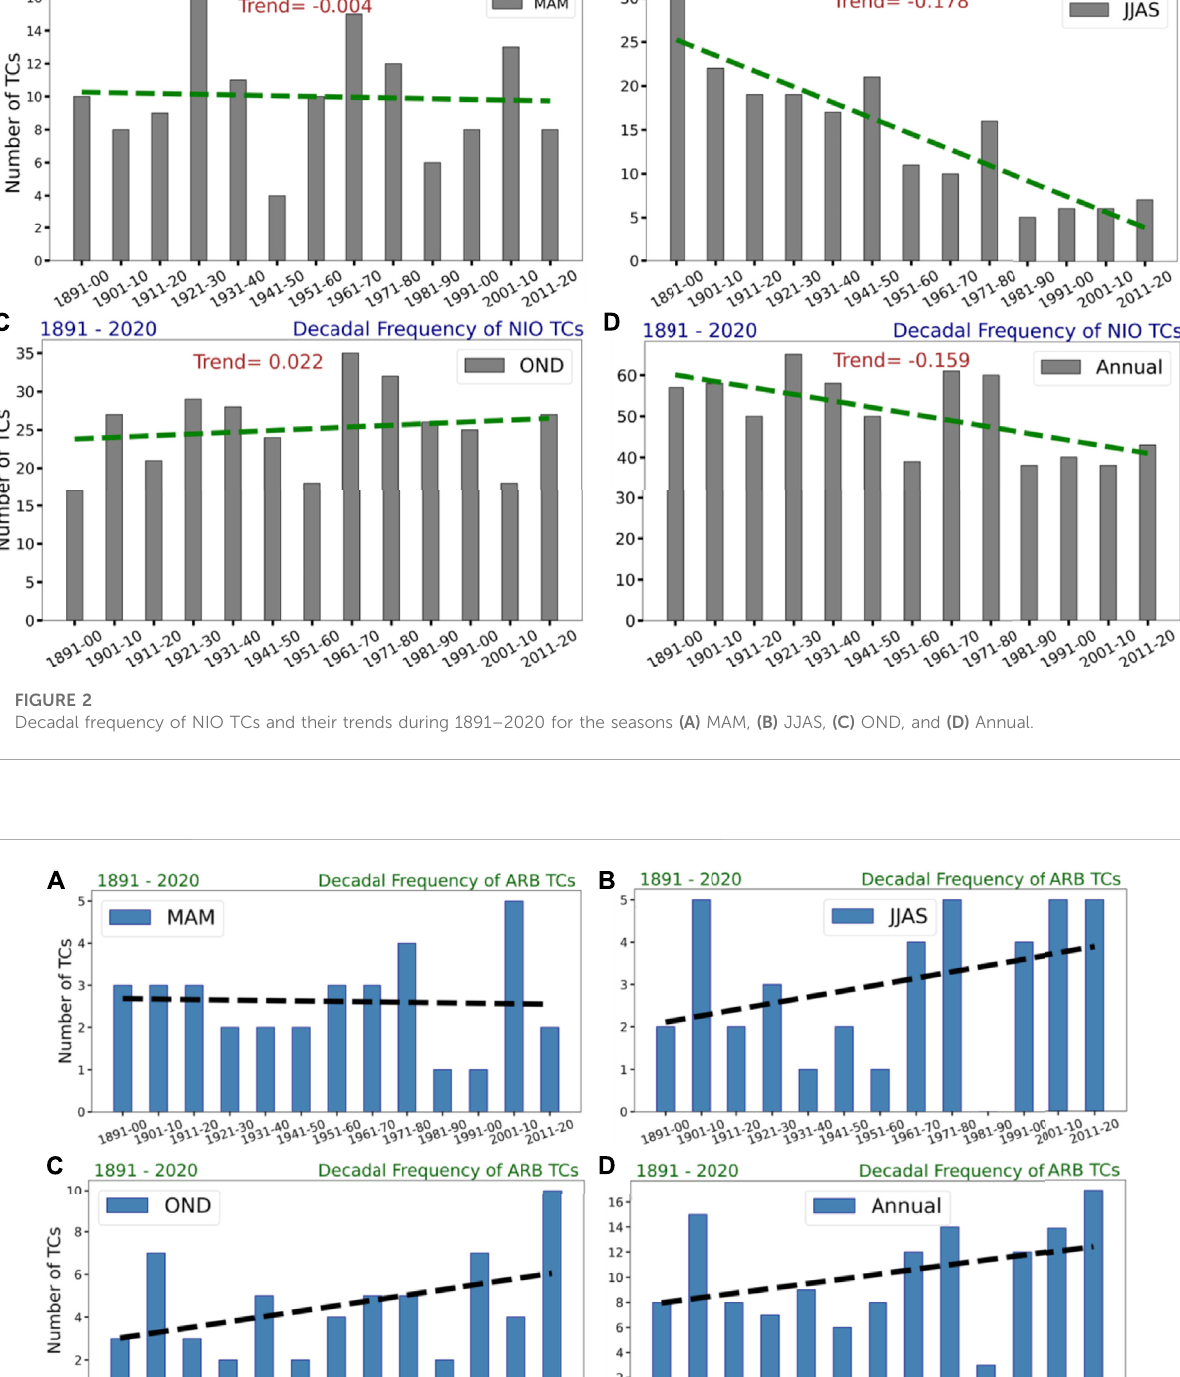
FIGURE 3 Decadal frequency of ARB TCs during 1891 – 2020 for the seasons (A) MAM, (B) JJAS, (C) OND, and (D) Annual.